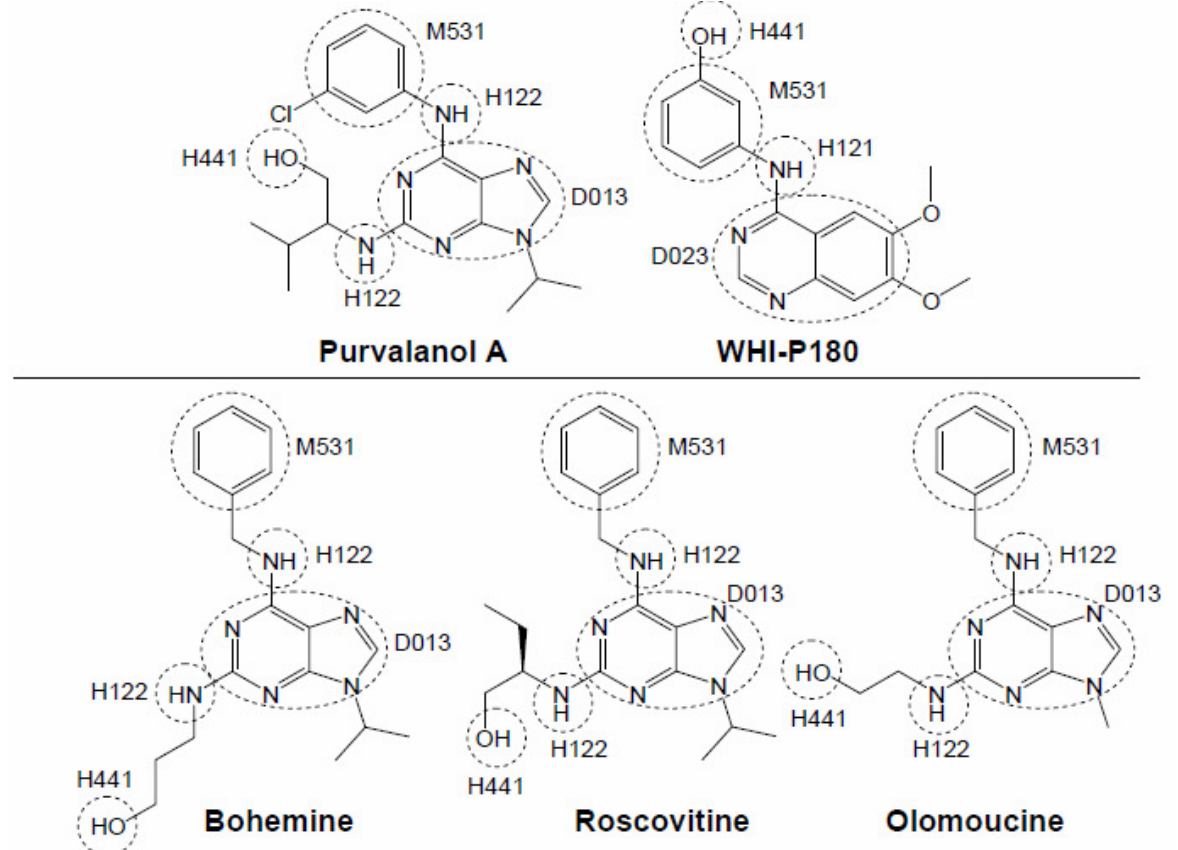
Figure 8. Chemical structures of CDK inhibitors: purvalanol A, WHI-P180, roscovitine, bohemine, and olomoucine. Chemical fragmentation codes involved in these CDK inhibitors were deduced by using the Markush TOPFRAG program (http://thomsonderwent.com/products/patentresarch/markushtopfrag/) (Derwent Information Ltd., London, UK) as described previously [47]. Information of each chemical fragmentation code is briefly summarized in Table